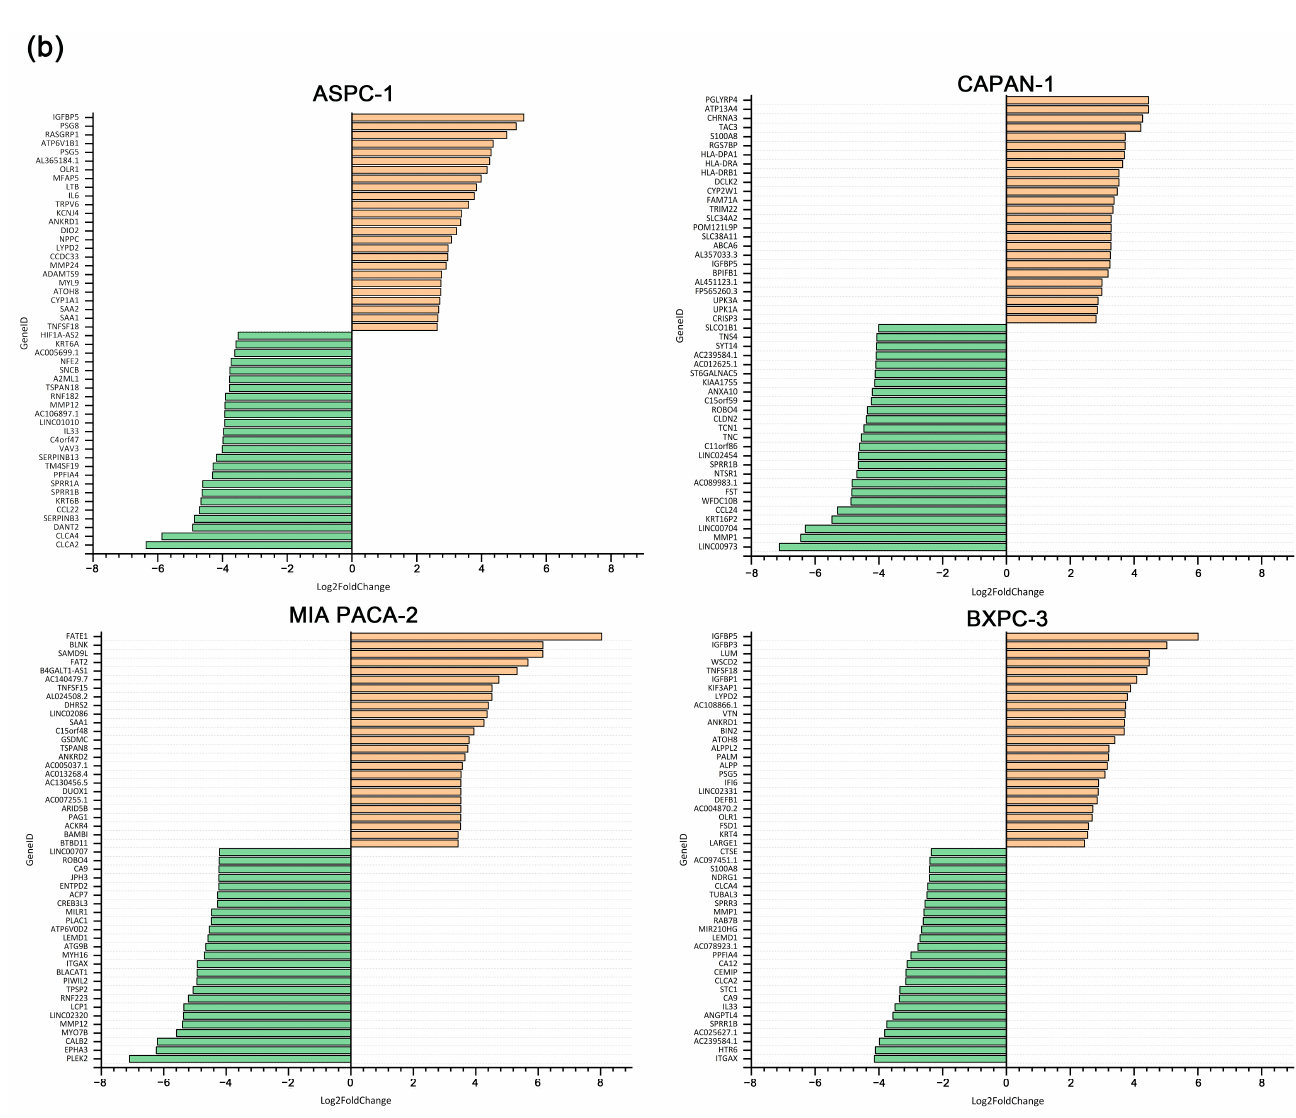
Figure 6. Number and overlap of DEGs in ASPC-1, BXPC-3, CAPAN-1 and MIA PACA-2 cell lines after exposure to BI-3406 combination ( a ) and the top 25 up- and down-regulated genes before and after BI-3406 combination exposure ( b ).